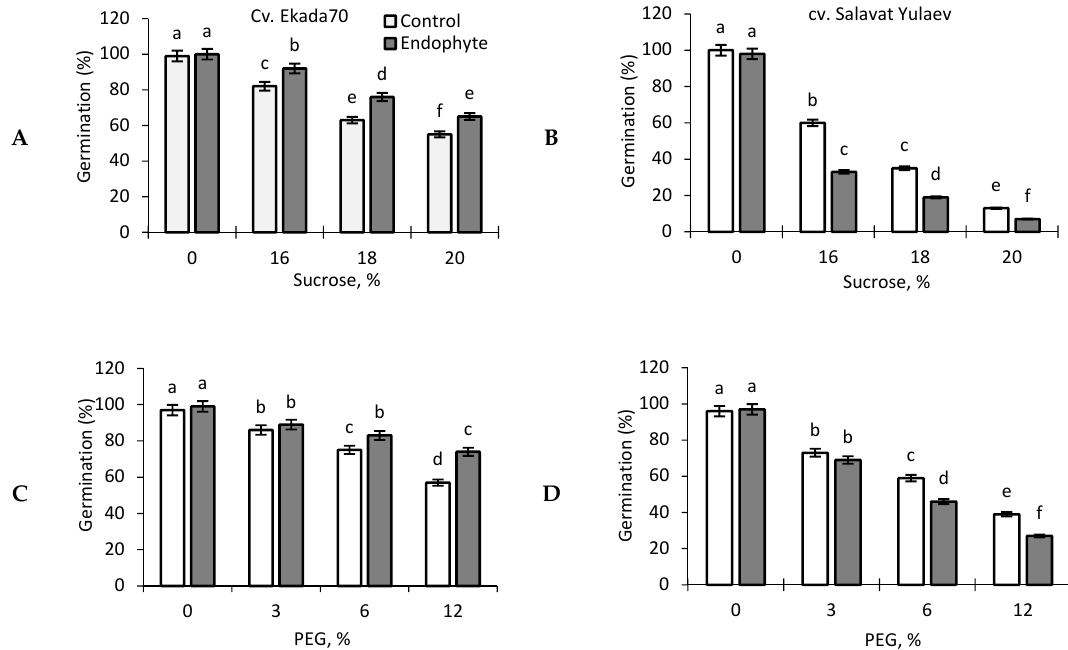
Figure 2. Effect of endophytic B. subtilis 10-4 (Endophyte) on the percentage of seed germination of wheat cv. Ekada70 ( A , C ), and cv. Salavat Yulaev ( B , D ) under high gradients of sucrose (Sucrose) (0, 16%, 18%, 20%) ( A , B ) and PEG–6000 (PEG) (0, 3%, 6%, 12%) ( C , D ). Control—non-inoculated seeds; Endophyte—seeds pre-inoculated with B. subtilis 10-4. The bars are the means of three repetitions ± SEM (n = 100, three replicates). Different letters indicate a significant difference between the means at the probability level of p < 0.05.